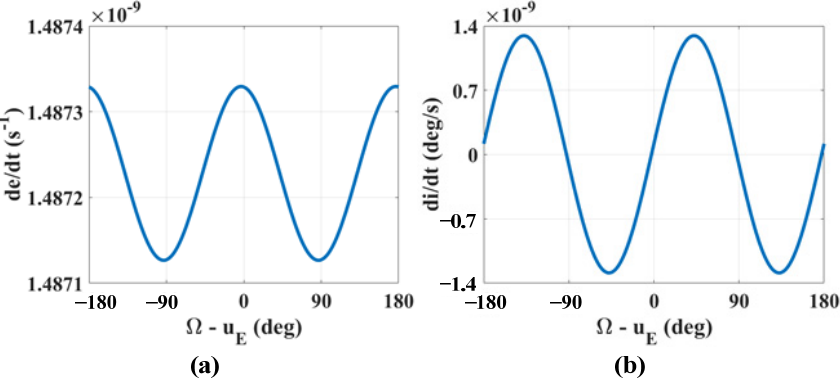
Figure 4. Rates of change of the eccentricity ( a ) and inclination ( b ), for a = 1.2 R E , e = 0.001, i = 93 ° , and ω = 35 ° .